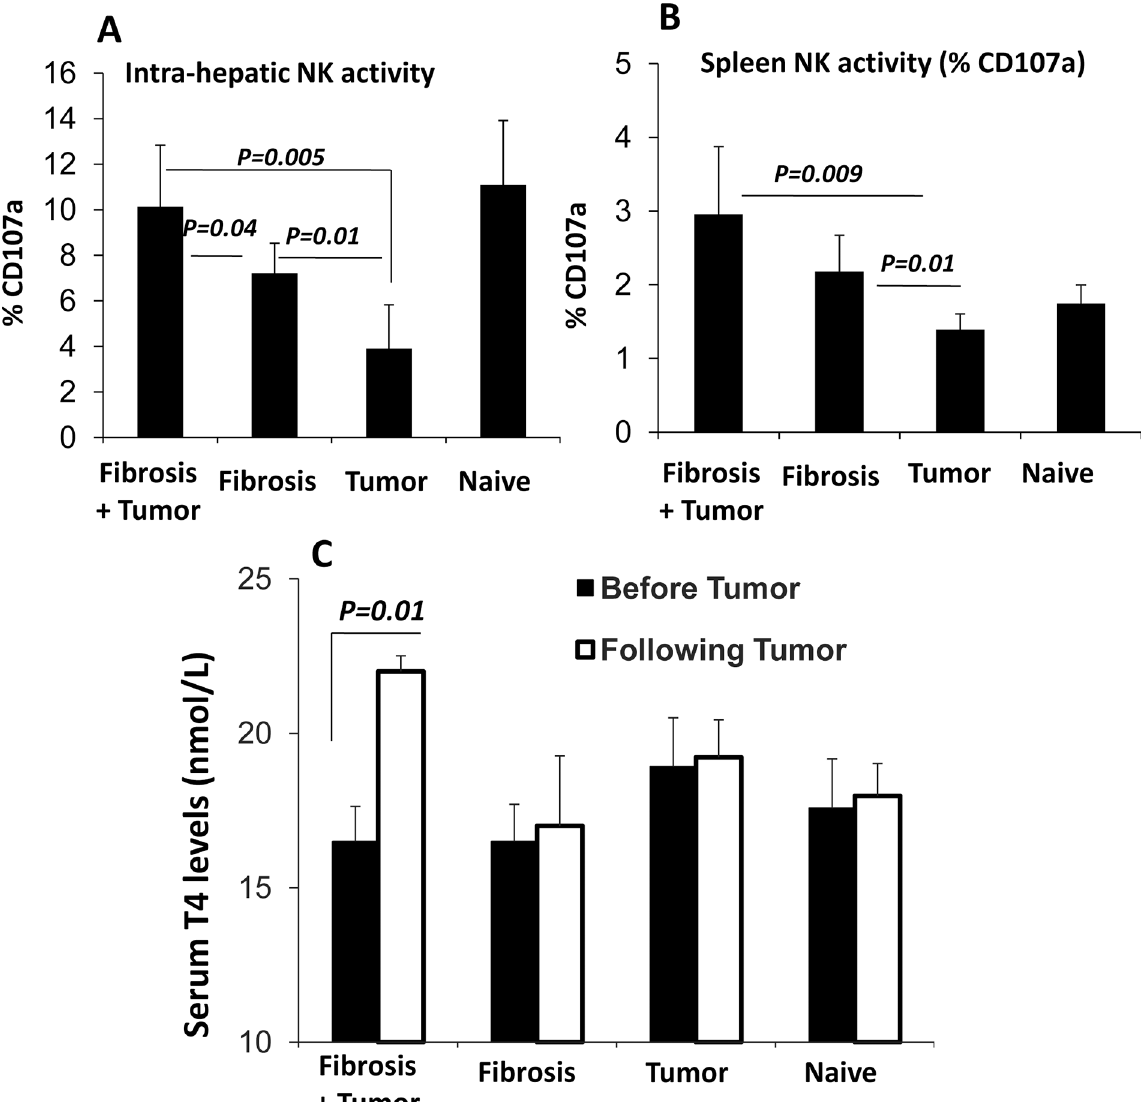
Fig 4. NK cell activity and T4 excretions increased in the fibrotic group with NPA tumor induction. (A) Intra-hepatic NK cells as well as (B) NK from spleen from four groups were isolated and stained for NK activity (CD107a) using flow-cytometry. The data showed a significant activation of the intrahepatic and splenic NK from the fibrotic group with NPA tumor induction compared to the non-tumor injected animals. (C) Shows serum T4 levels significantly elevated in animal models of fibrosis following NPA tumor